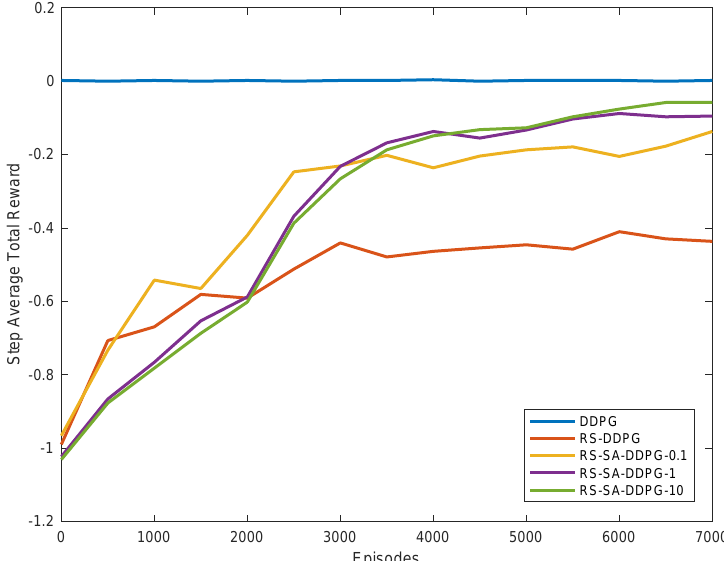
Figure 9. The convergence curve of weight w of the linear combination of aerial combat